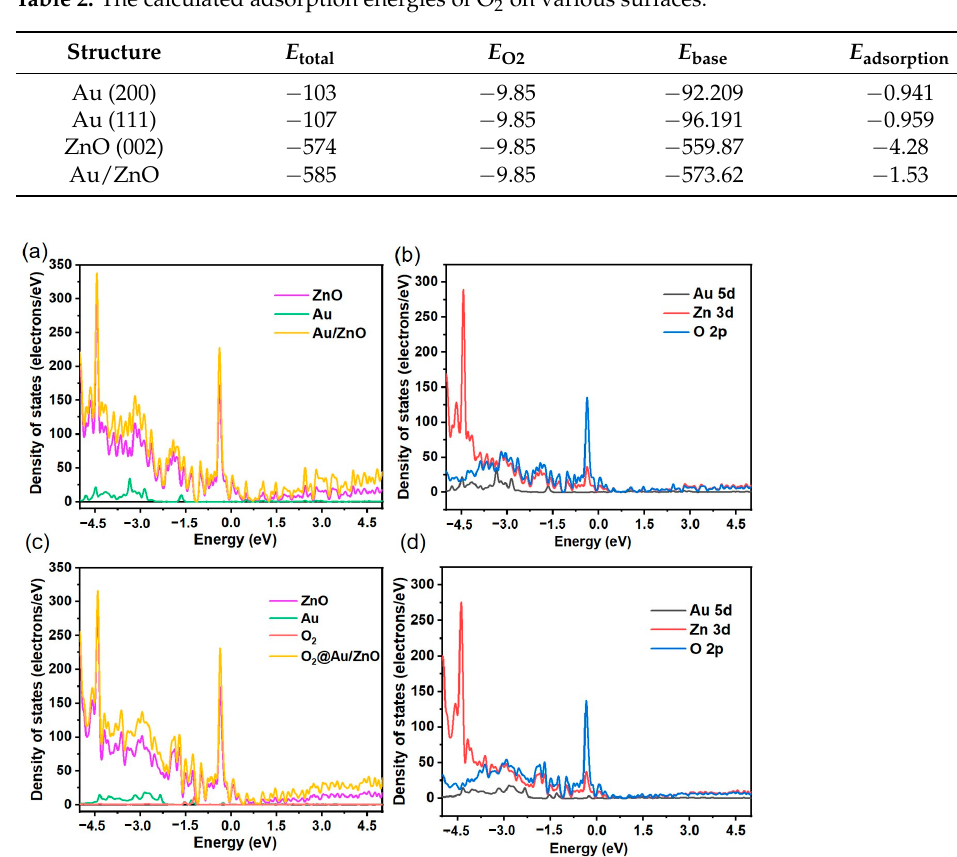
Figure 12. ( a ) TDOS and ( b ) PDOS before minor O 2 molecule adsorption of ZnO, Au, and Au/ZnO. ( c ) TDOS and ( d ) PDOS after minor O 2 molecule adsorption of ZnO, Au, and Au/ZnO.